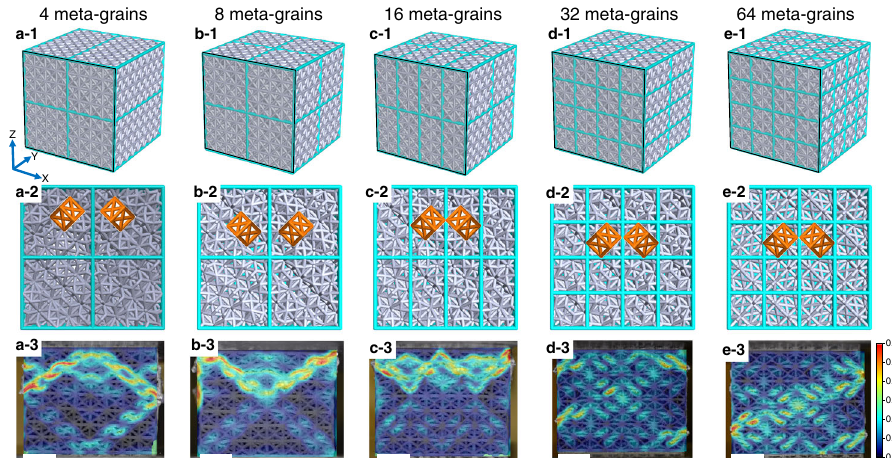
Fig. 5 Models demonstration and deformation behaviours of polygrain-like meta-crystals. Strain distribution at 20% strain on meta-crystals with respect to different lattice con fi gurations after digital image correlation analyses, where unit-cell orientation and boundary location are highlighted. a 4 meta-grains. b 8 meta-grains. c 16 meta-grains. d 32 meta-grains. e 64 meta-grains, where the colour bar indicates the maximum shear strain and the length-scale bar is